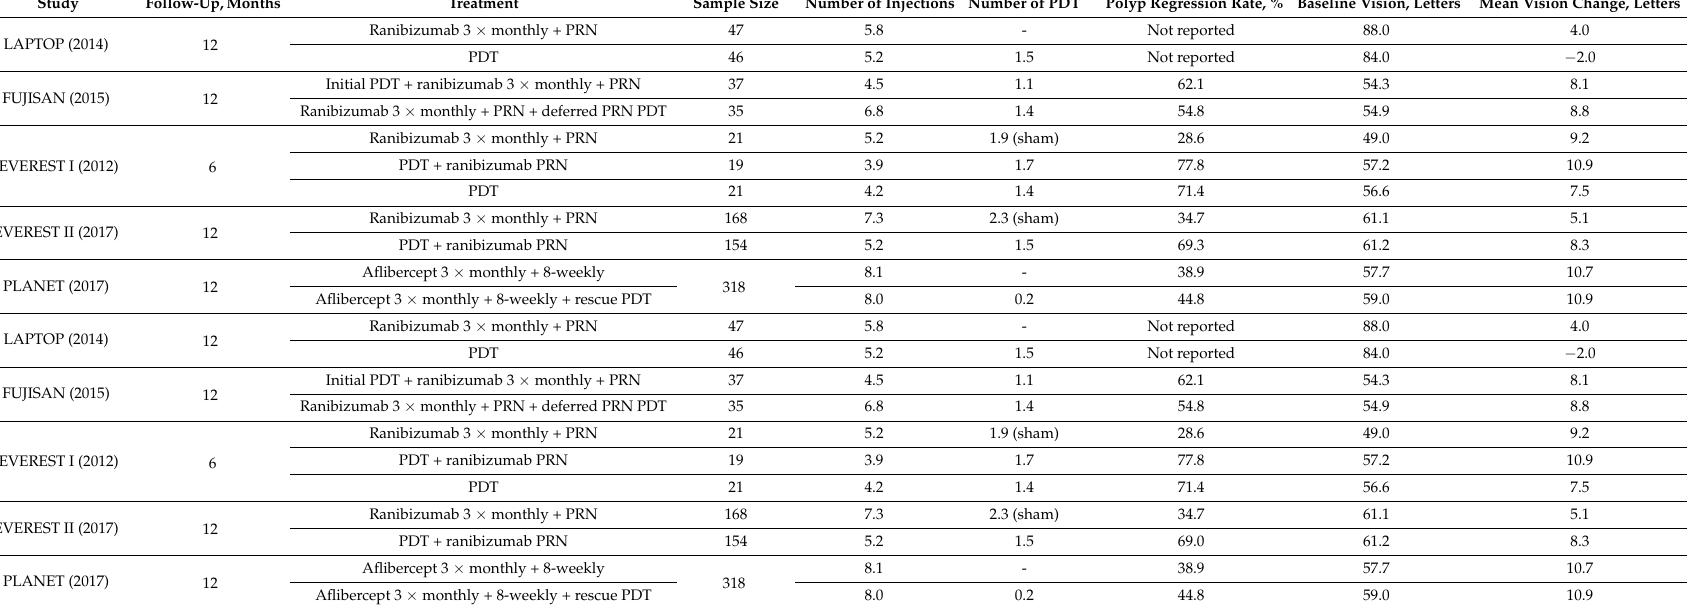
Table 1. Summary of randomized controlled trials in the treatment of polypoidal choroidal vasculopathy (PCV). Study Treatment Sample